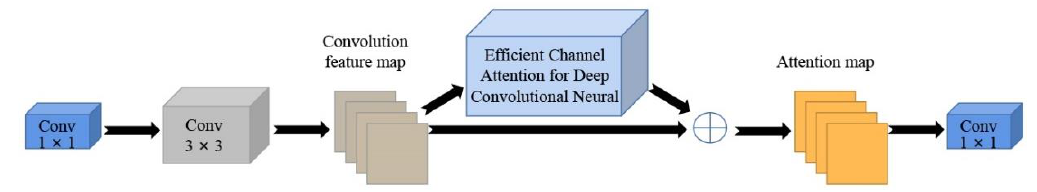
Figure 5. Adding the residual block structure of the ECA attention mechanism.